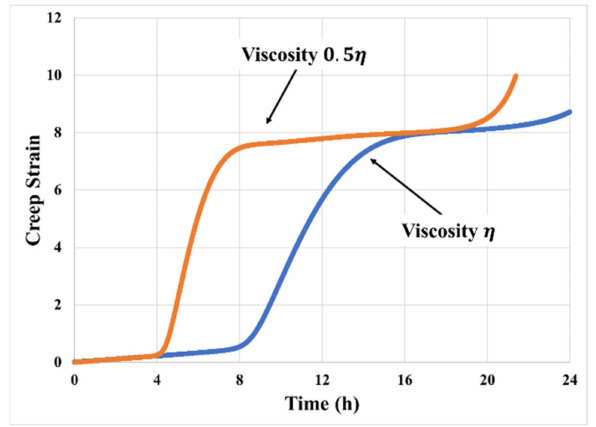
Figure 17. Effects of PSA viscosity (and stress relaxation time) on creep model prediction (50 kPa, 70 ◦ C).